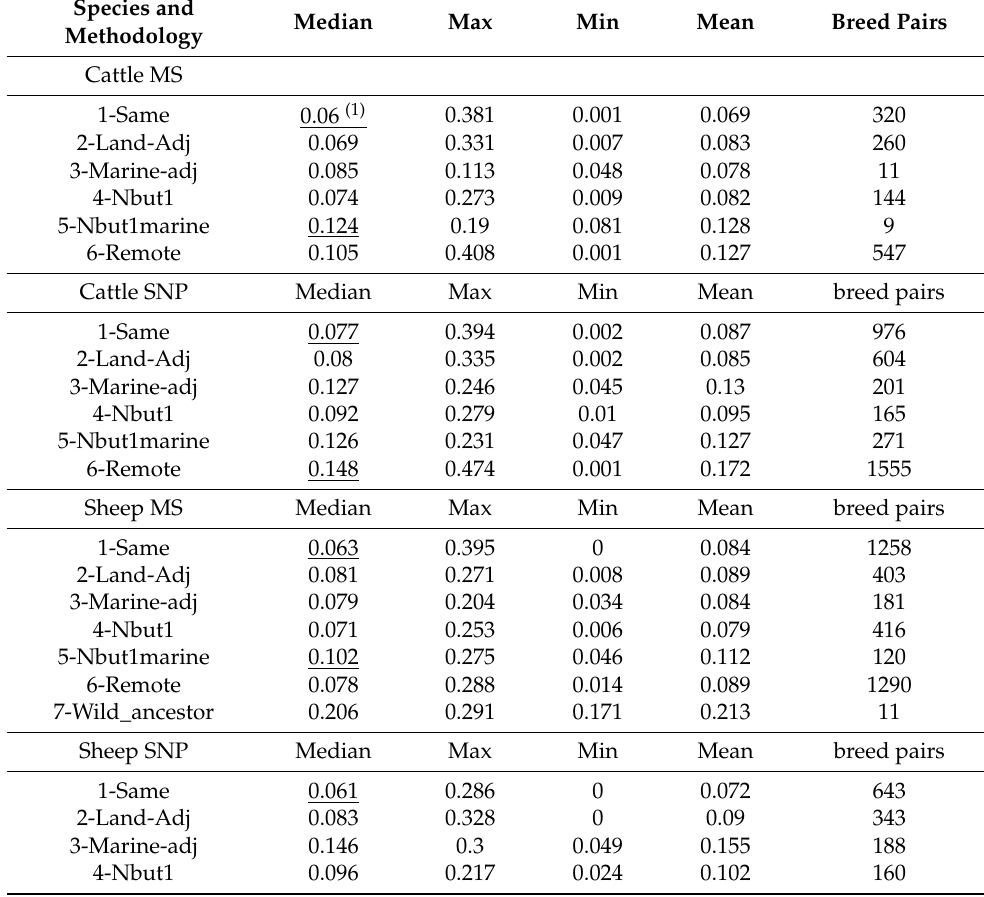
Table 5. Summary statistics for F st between breed pairs, classified by method (MS and SNP) and by spatial relationships between breeds. For definitions as abbreviated here, see Table